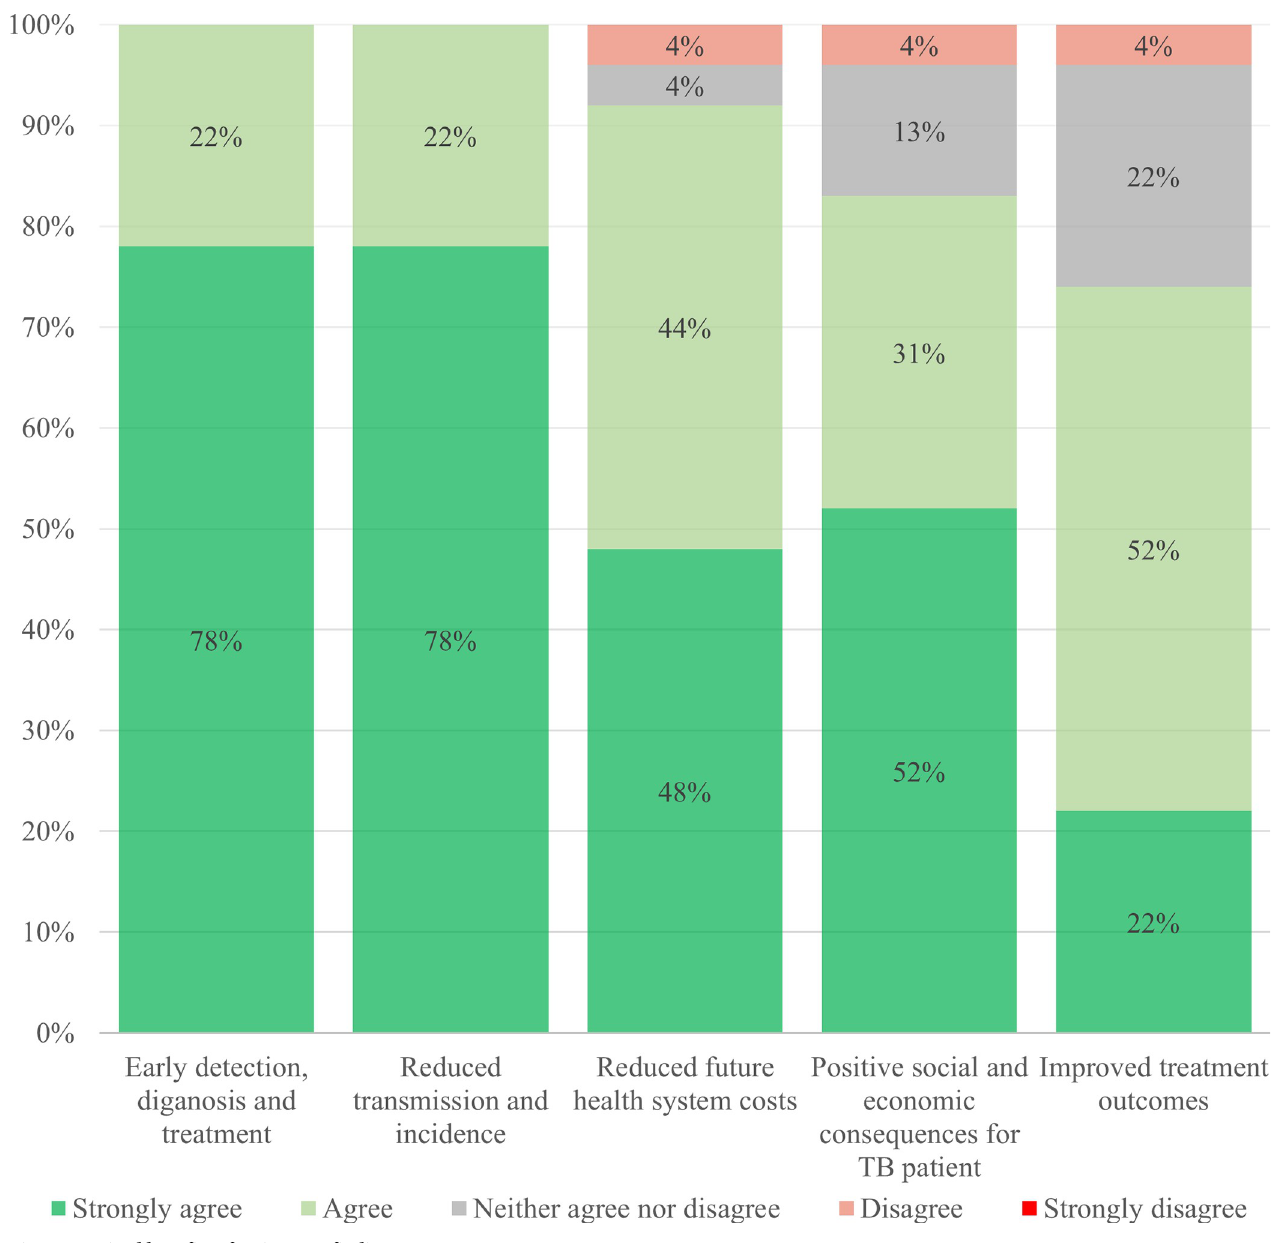
Fig 3. Perceived benefits of active